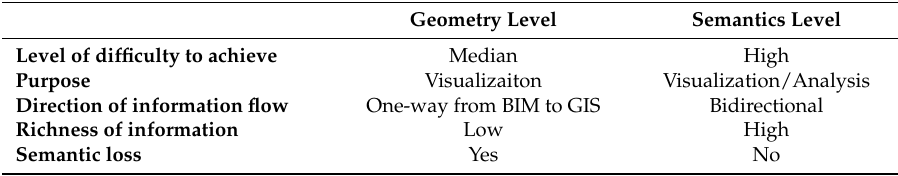
Table 1. Comparison between integration at geometry and semantic